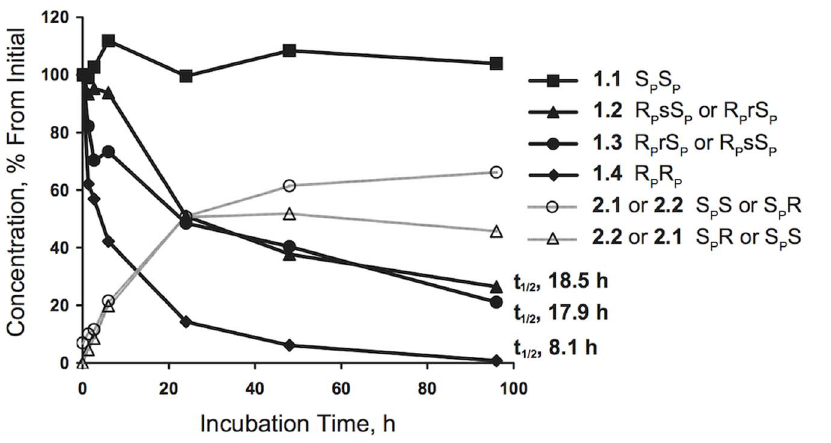
Figure 5. Stability and metabolism of the four diastereomers of compound 1 in human plasma at 37 6 C. t 1/2 , half-life of first order elimination. For other abbreviations, see Figure